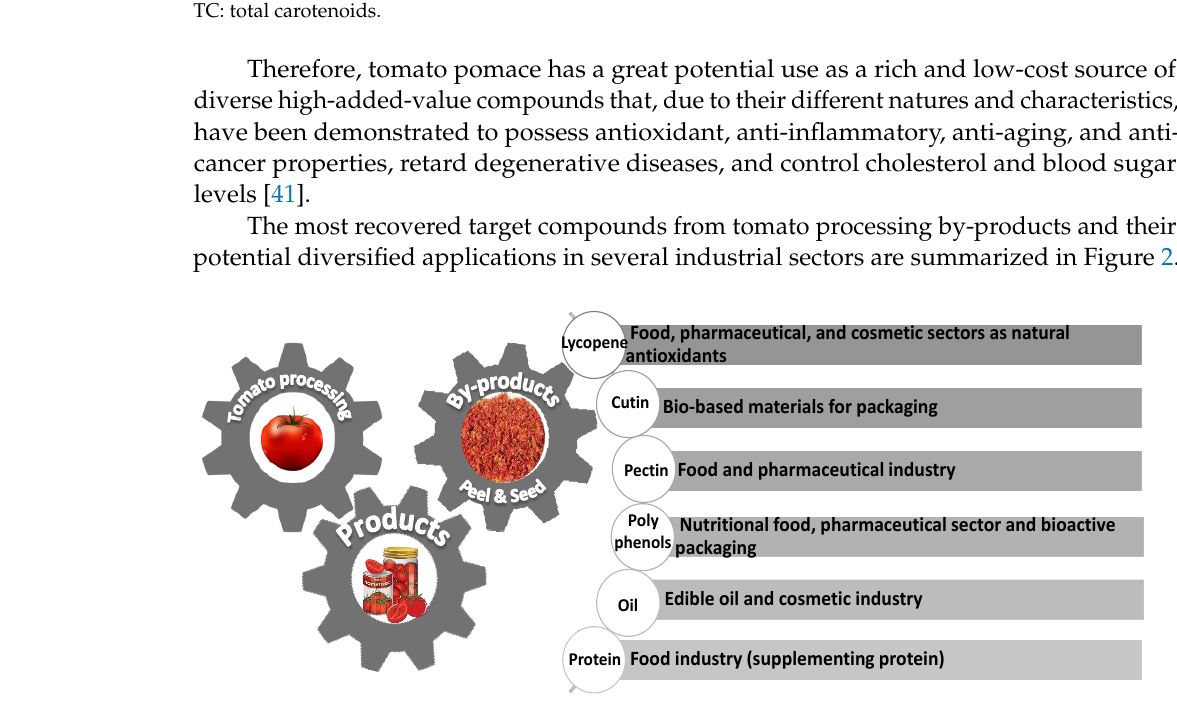
Figure 2. Schematic of tomato processing by-product valorization, compounds recovered, and their potential fields of application.